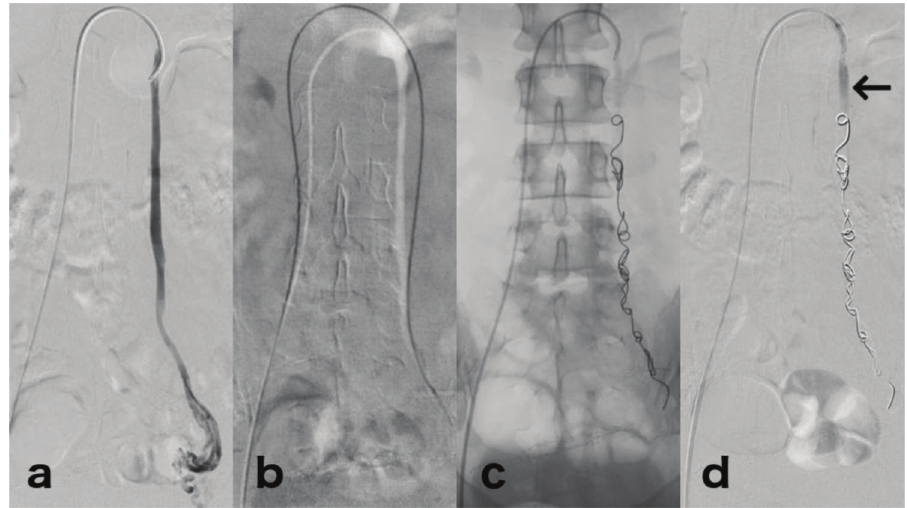
Figure 2 - Embolization technique. (a) Venography pre-embolization with reflux in the left ovarian vein to periuterine veins. (b) Left ovarian vein catheterization to its distal segment using angiographic catheter over a hydrophilic guide wire. (c) Radiography after embolization, showing fibered metallic coils from the distal segment of the left ovarian vein to its proximal third. (d) Venography post- embolization, with complete occlusion of the vessel. Note the contrast material only in the proximal segment of the left ovarian vein